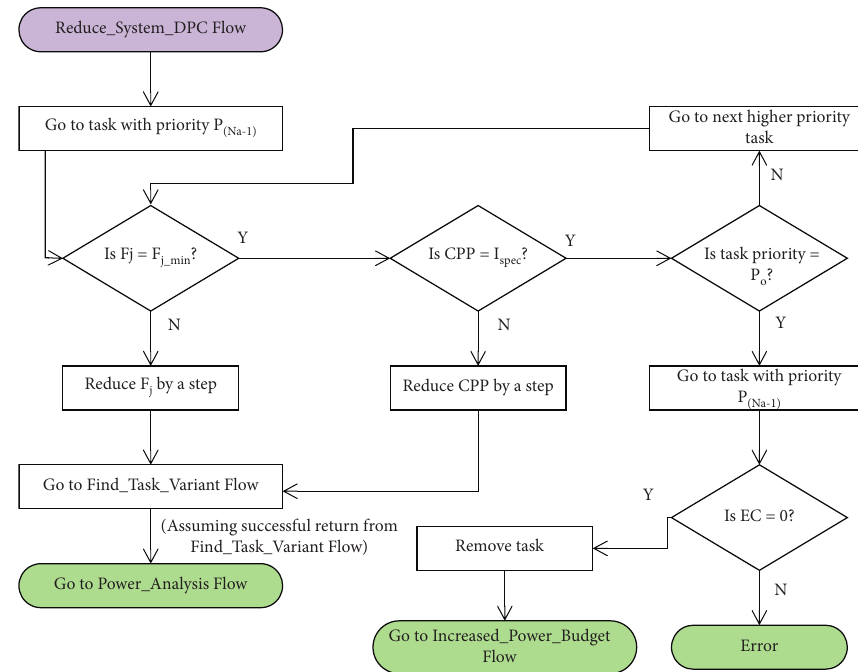
Figure 9: Reduce_System_DPC flow of Explorer.